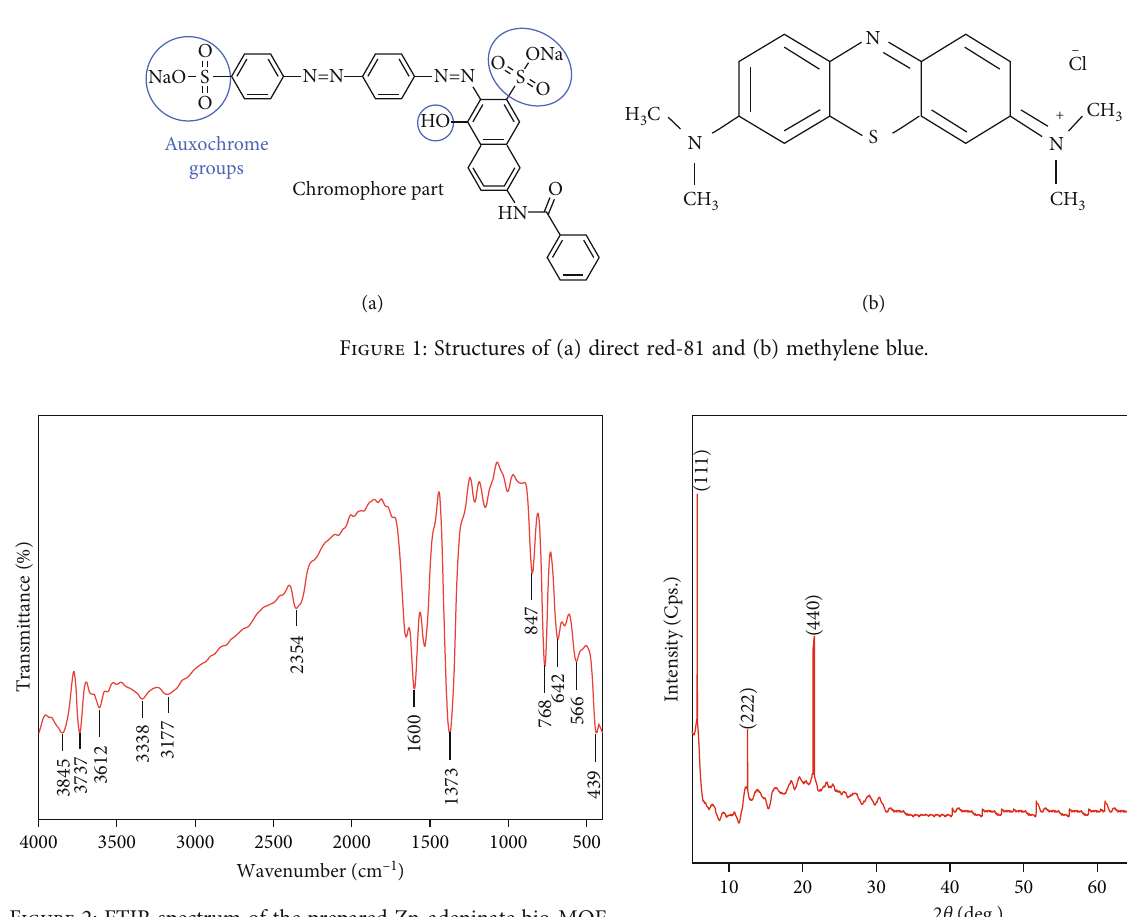
Figure 2: FTIR spectrum of the prepared Zn-adeninate bio-MOF.